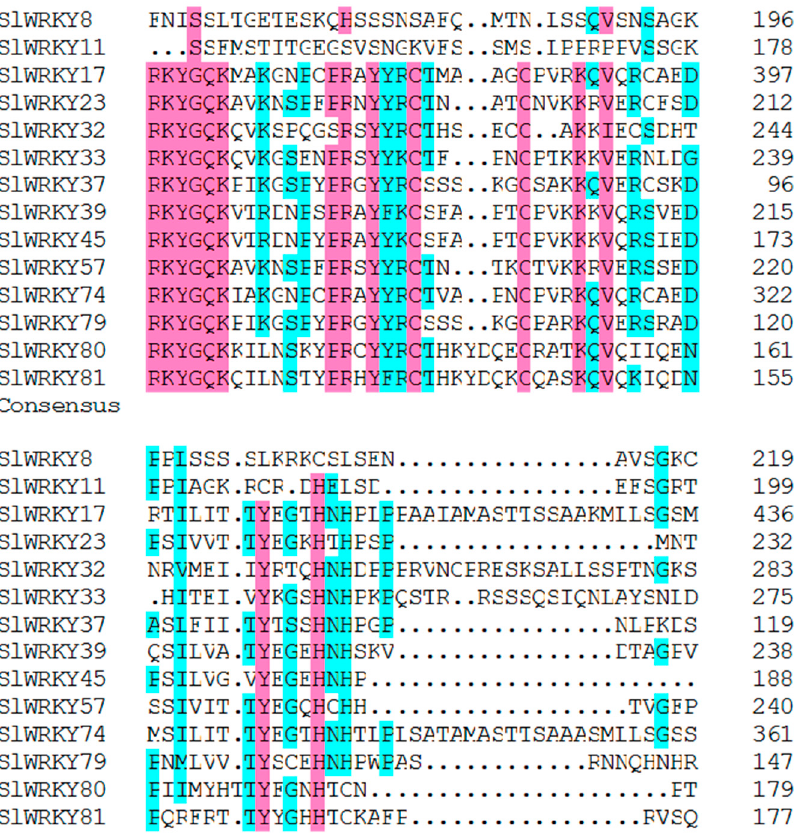
Figure 1. Alignment of the SlWRKY79 protein sequence with those of SlWRKY8, SlWRKY11, SlWRKY17, SlWRKY23, SlWRKY32, SlWRKY33, SlWRKY37, SlWRKY39, SlWRKY45, SlWRKY57, SlWRKY74, SlWRKY80, and SlWRKY81. Pink means higher similarity, light blue means lower similarity.